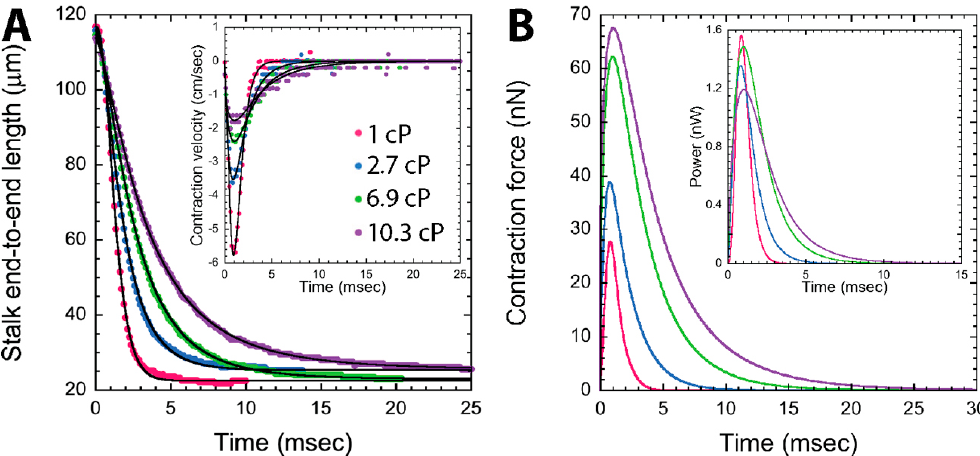
Figure 10. The stalk contraction dynamics and energetics of V. convallaria (reproduced from [9]). ( A ) Time courses of the stalk length and contraction speed (inset); ( B ) contractile force and power (inset) calculated from the velocity profile. 1 cP (centipoise) is the dynamic viscosity of water (= 0.1 Pa · s). As the medium viscosity increased, V. convallaria contracted slower with higher contractile force while the peak power was limited.